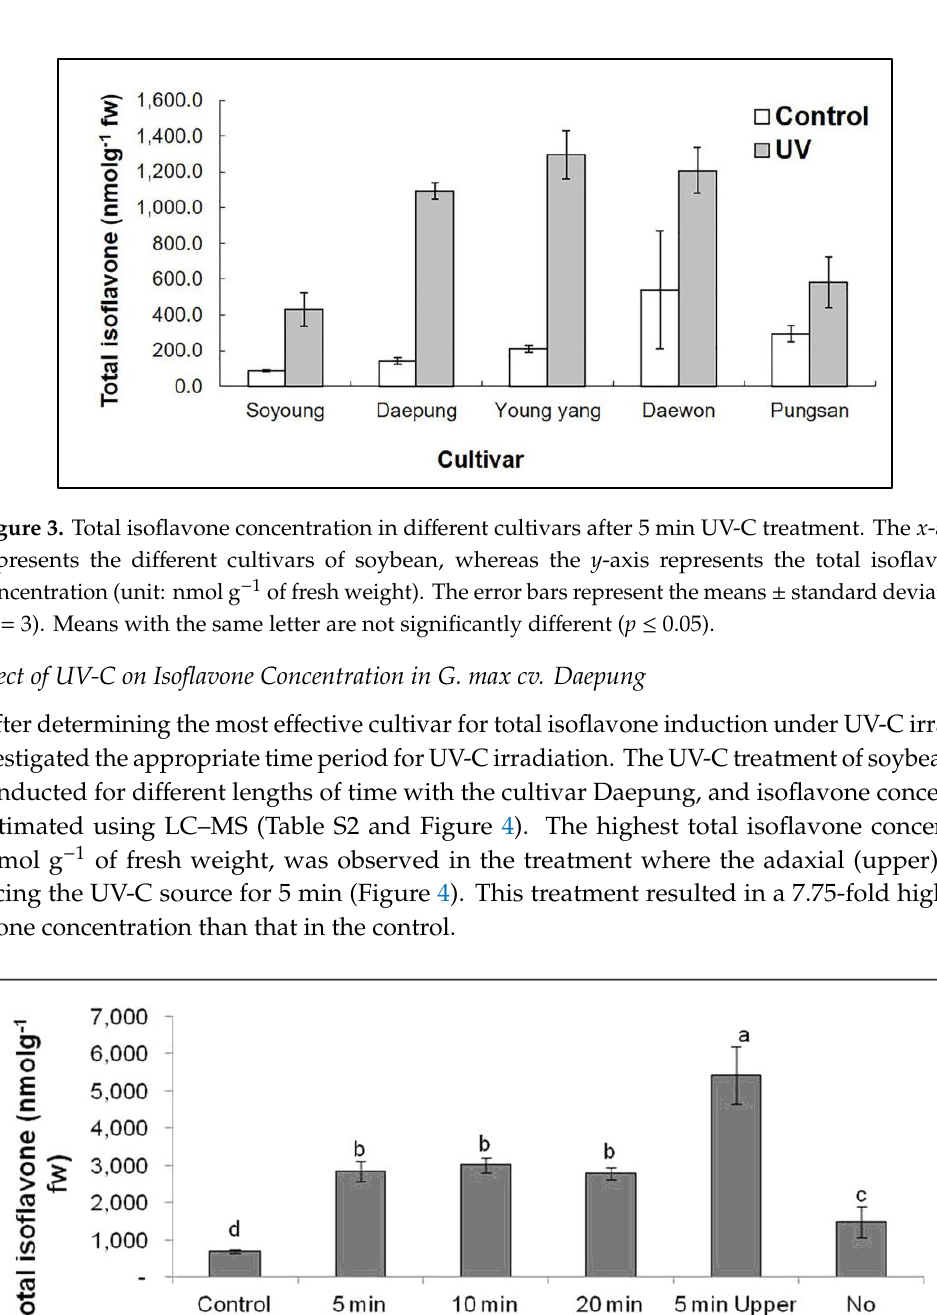
Figure 3. Total isoflavone concentration in different cultivars after 5 min UV-C treatment. The x -axis represents the different cultivars of soybean, whereas the y -axis represents the total isoflavone concentration (unit: nmol g −1 of fresh weight). The error bars represent the means ± standard deviation ( n = 3). Means with the same letter are not significantly different ( p ≤ 0.05).